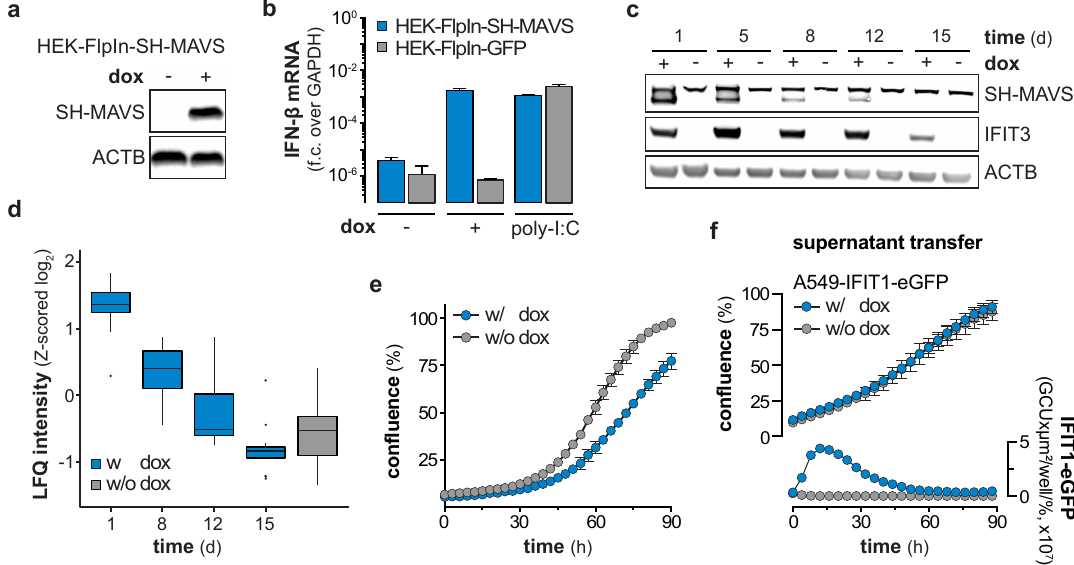
Figure 5. Counter selection of mitochondrial antiviral signaling protein (MAVS) expressing cells. ( a ) Western blot showing protein expression levels of StrepII-HA-tagged MAVS (SH-MAVS) and β -actin(ACTB) in doxycycline (dox)-treated HEK-FlpIn-MAVS cells. ( b ) IFN- β mRNA levels in HEK-FlpIn-GFP or -SH-MAVS cells, non-treated, 1 µ g / mL dox-treated or poly-I:C (1 µ g / 1 × 10 6 cells) transfected for 1 day. Fold change (f.c.) over GAPDH was calculated (mean + s.d. of n = 2 technical replicates). ( c ) Western blot of SH-MAVS, IFIT3, and ACTB protein expression in HEK-FlpIn-MAVS cells non-treated or continuously treated with 1 µ g / mL dox for the indicated days. ( d ) Total proteome analysis of HEK-FlpIn-MAVS cells non-treated or 1 µ g / mL dox-treated for the indicated days. Box and whisker plots (median, hinges: 1st and 3rd quartiles, whiskers: ± 1.5 × inter-quartile-range) represent row-wise Z-scored median log 2 LFQ intensities ( n = 4 technical replicates) of proteins, overlapping with proteins significantly upregulated at 6 days post NS5B WT transduction. ( e ) Cell growth assay of HEK-FlpIn-MAVS cells non-treated or 1 µ g / mL dox-treated for the indicated hours (mean ± s.d. of n = 9 technical replicates). One representative of n = 3 independent experiments is shown. ( f ) Cell growth and IFIT1-eGFP expression of A549-IFIT1-eGFP cells stimulated with the supernatant of 1 day 1 µ g / µ L dox-treated HEK-FlpIn-MAVS cells (mean ± s.d. of n = 4 technical replicates of n = 3 independent experiments). Left y-axis shows the percentage confluence and the right y-axis the IFIT1-eGFP expression based on the confluence-normalized green integrated intensity per